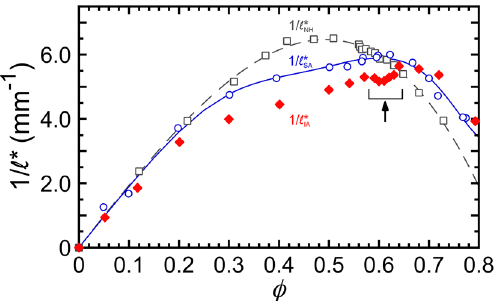
Figure 1. Measured inverse mean free path of optical transport, 1 /ℓ ∗ , of fractionated silicone oil-in-water (O/W) emulsions as a function of droplet volume fraction, φ , for three different strengths of micellar depletion attraction (pathlength L = 5.0 mm, light wavelength (cid:31) = 685 nm). Intermediately attractive (this study, [SDS] = 35 mM, | U d | ≈ 6 k B T , average droplet radius (cid:31) a (cid:30) = 484 nm): 1 /ℓ ∗ IA (red solid diamonds). Nearly hard interactions (Kim et al. 47 , [SDS] = 10 mM, | U d | < k B T , similar (cid:31) a (cid:30) = 459 nm): 1 /ℓ ∗ NH (gray open squares); fit (gray dashed line) using Eq. (6) in Xu et al. 60 . Strongly attractive (Xu et al. 60 , [SDS] = 80 mM, | U d | ≈ 15 k B T , (cid:31) a (cid:30) = 459 nm): 60 using Eq. (5) in Xu et al. 60 with constraints imposed 1 /ℓ ∗ SA (blue open circles); fit (blue solid line) from Xu et al. by Eqs. (1-4) in Xu et al. 60